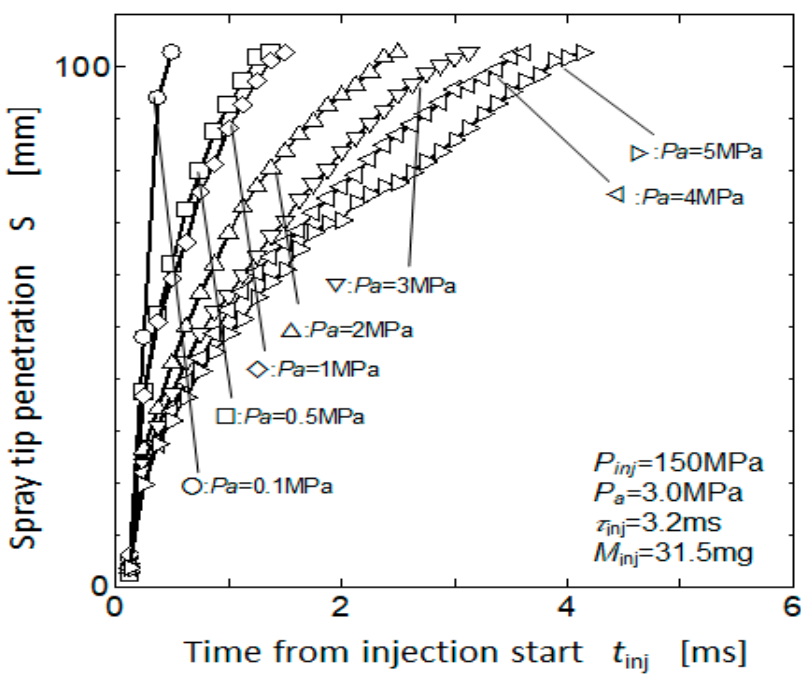
Figure 8. Tip penetration of diesel spray [19,20]. Table 2. Basic data for breakup scale estimation.